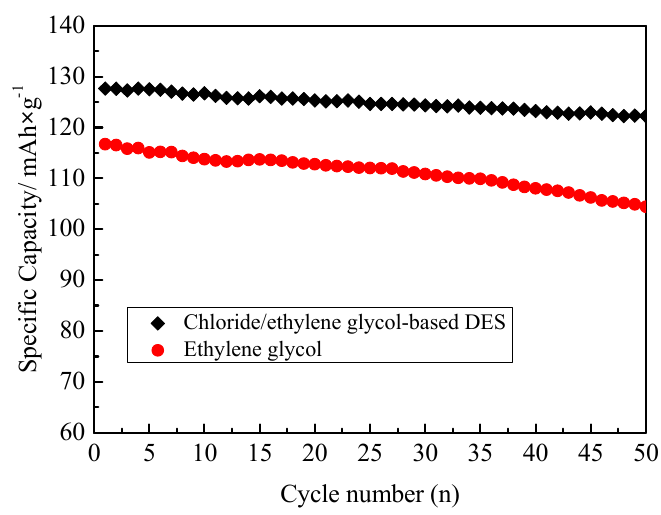
Figure 8. The 1 C rate cycling performance of the LiMnPO 4 /C prepared in DES and EG, respectively.